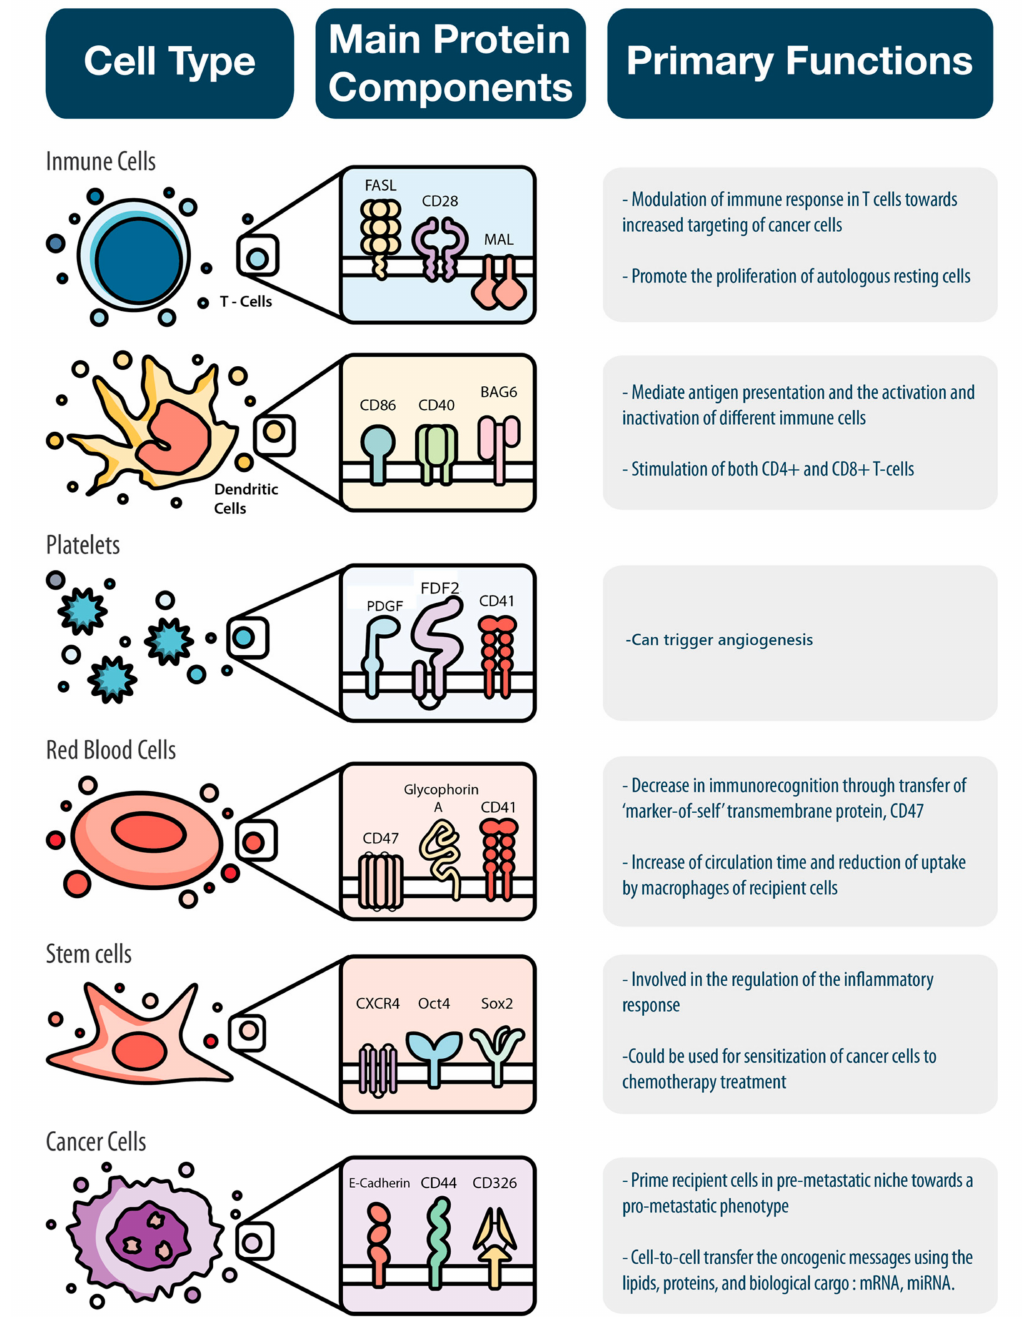
Figure 2. EVs deliver specific biological messages according to the cell type from where they originated. Immune cells, platelets, red blood cells, stem cells, and cancer cells were analyzed in this paper based on their main protein component and the specific biological message they